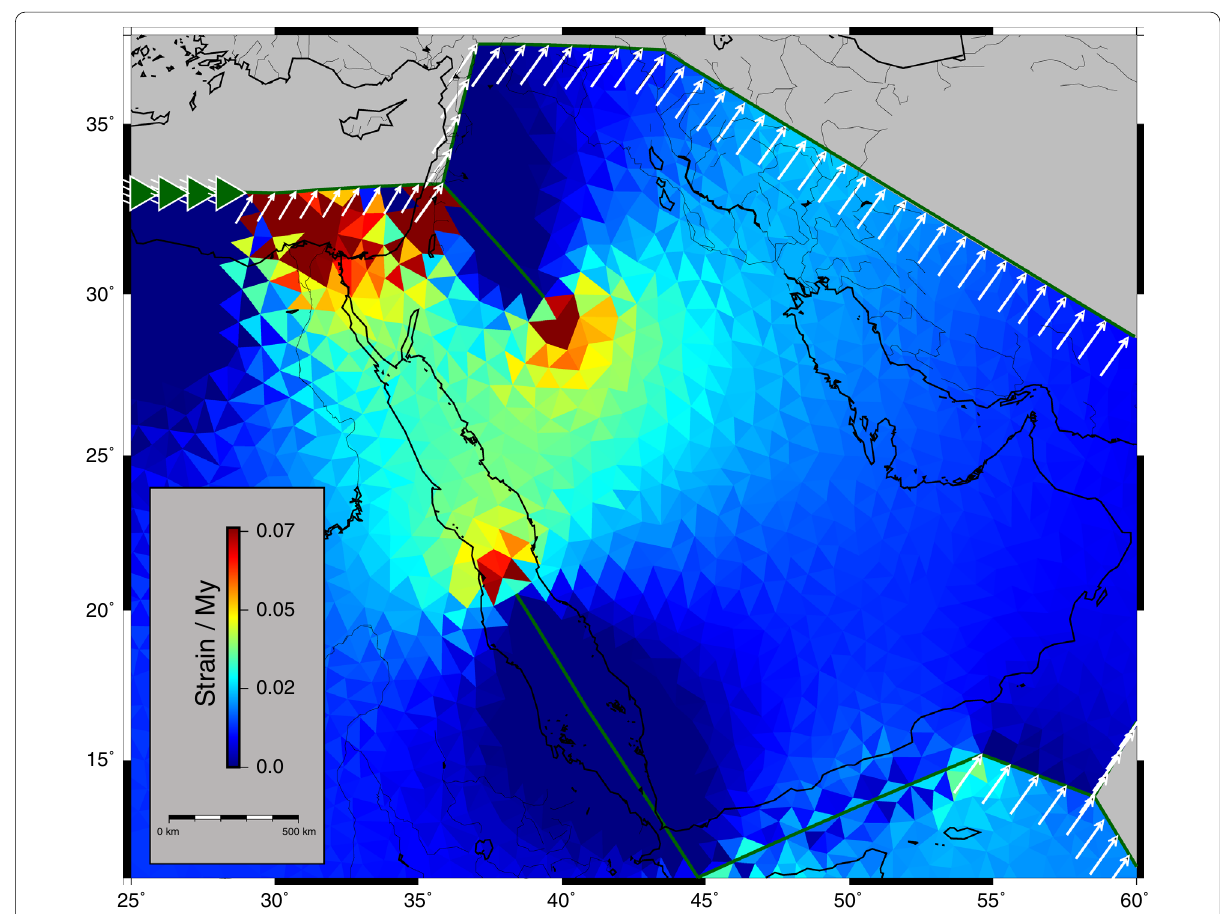
Fig. 5 Strain rate map that correspond to the increase of velocity in the eastern Mediterranean with keeping the rest of the boundary conditions as described in Fig. 3. This process demonstrates that during the period between development of the Nile River zone (30–28 Ma) until the dike intrusions event (25 Ma) hyperextension was taking place along the NRS, and dilatational strain rate diffuses from the Egyptian western dessert to the Sirhan rift. Although the deformation becomes more diffuse in comparison with Fig. 4, the strain zone linking the SRS and the Sirhan rifts still bounds the diffuse extension area to the south. For simplicity, we use a homogenous elastic domains in which the dilatational strain tends to be uniformly